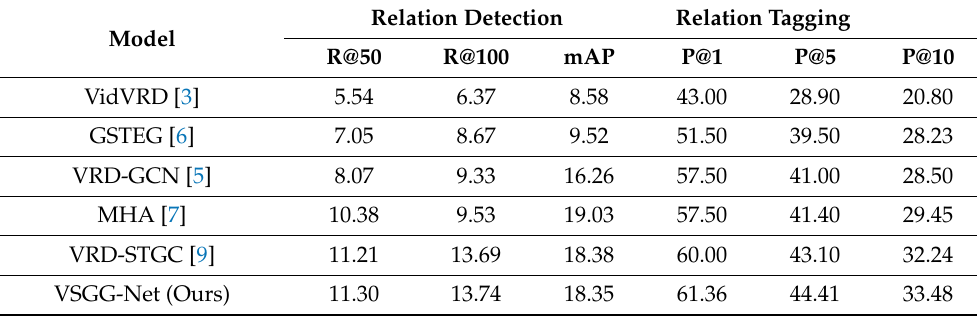
Table 7. Comparison of the proposed method with state-of-the-art models on VidVRD test set.